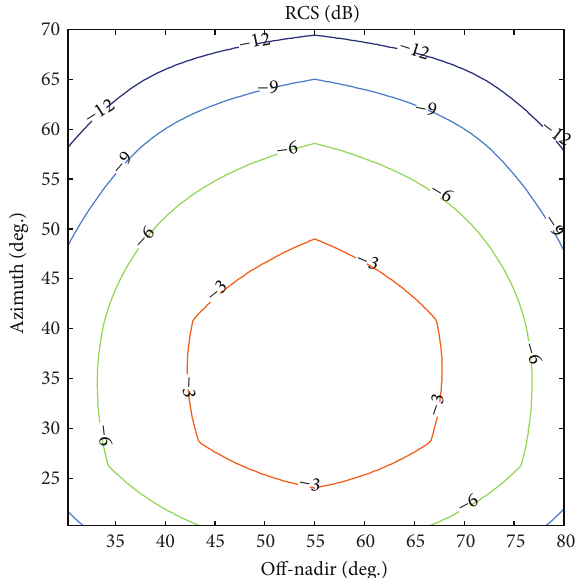
Figure 5: Contours of constant relative RCS for rectangular trihe- dral corner